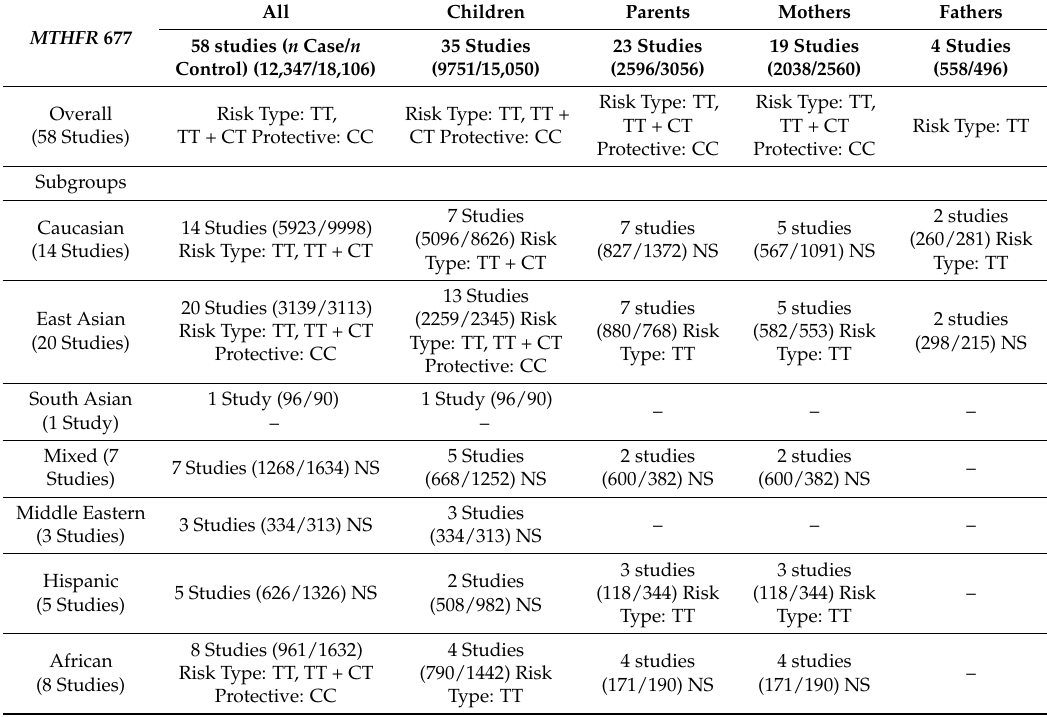
Table 1. Schema of significant findings across studies on MTHFR 677 genotypes and risk of congenital heart diseases